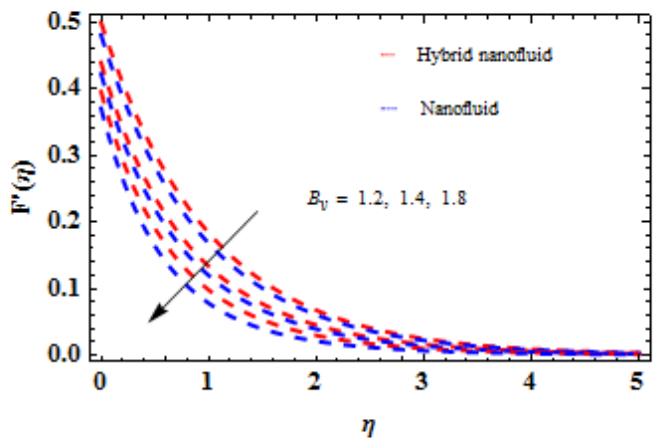
Figure 18. Influence of B v via dust velocity.